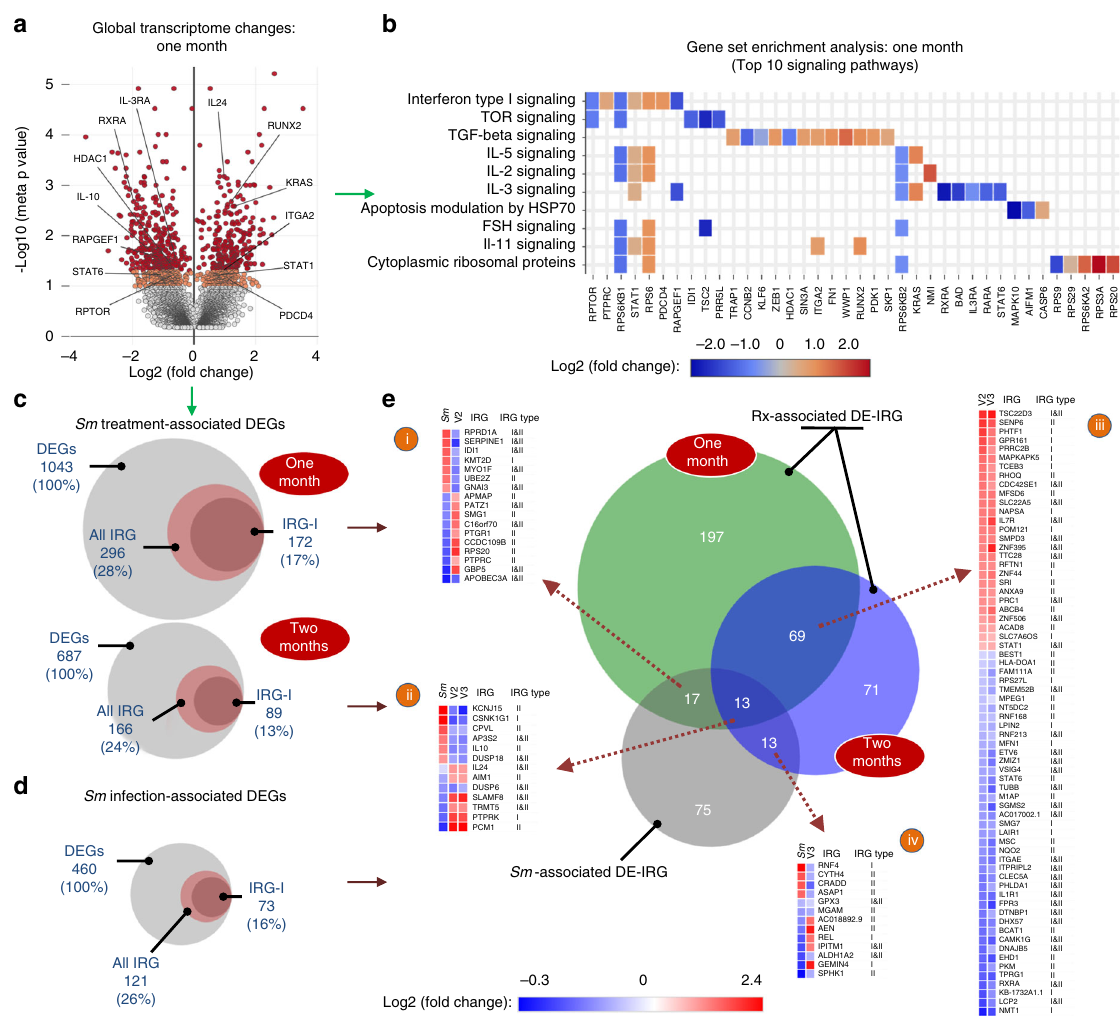
Fig. 4 Systemic transcriptome and IFN-I signaling changes associated with Sm treatment. a Global distribution of fold changes and p-values derived from the analysis of genes differentially expressed at one-month post- Sm treatment. Red and orange dots denote genes with meta-analysis p values ≤ 0.05 and 0.05 < p ≤ 0.1, respectively. Cumulatively, out of n = 8459 genes, 12.3% ( n = 1043) were differentially expressed (red and orange), and of the latter 559 (54.0%) were down- and 484 (46.0%) up-regulated. Labels on the volcano plot denote select genes appearing in the gene set enrichment analysis (Fig. 4b); RPTOR (regulatory-associated protein of mTOR), STAT (signal transducer and activator of transcription) 1 and 6, RAPGEF (rap guanine nucleotide exchange factor) 1, HDAC (histone deacetylase) 1, RXRA (retinoid X receptor α ), IL-3RA (interleukin 3 receptor α ), RUNX (runt-related transcription factor) 2, KRAS (Kirsten rat sarcoma), ITGA (integrin α ) 2, PDCD (Programmed Cell Death) 4, and those discussed in the text; IL (interleukin) − 10 and IL-24. b The top 10 enriched pathways identi fi ed by the gene set enrichment analysis using all differentially expressed genes (DEG) identi fi ed